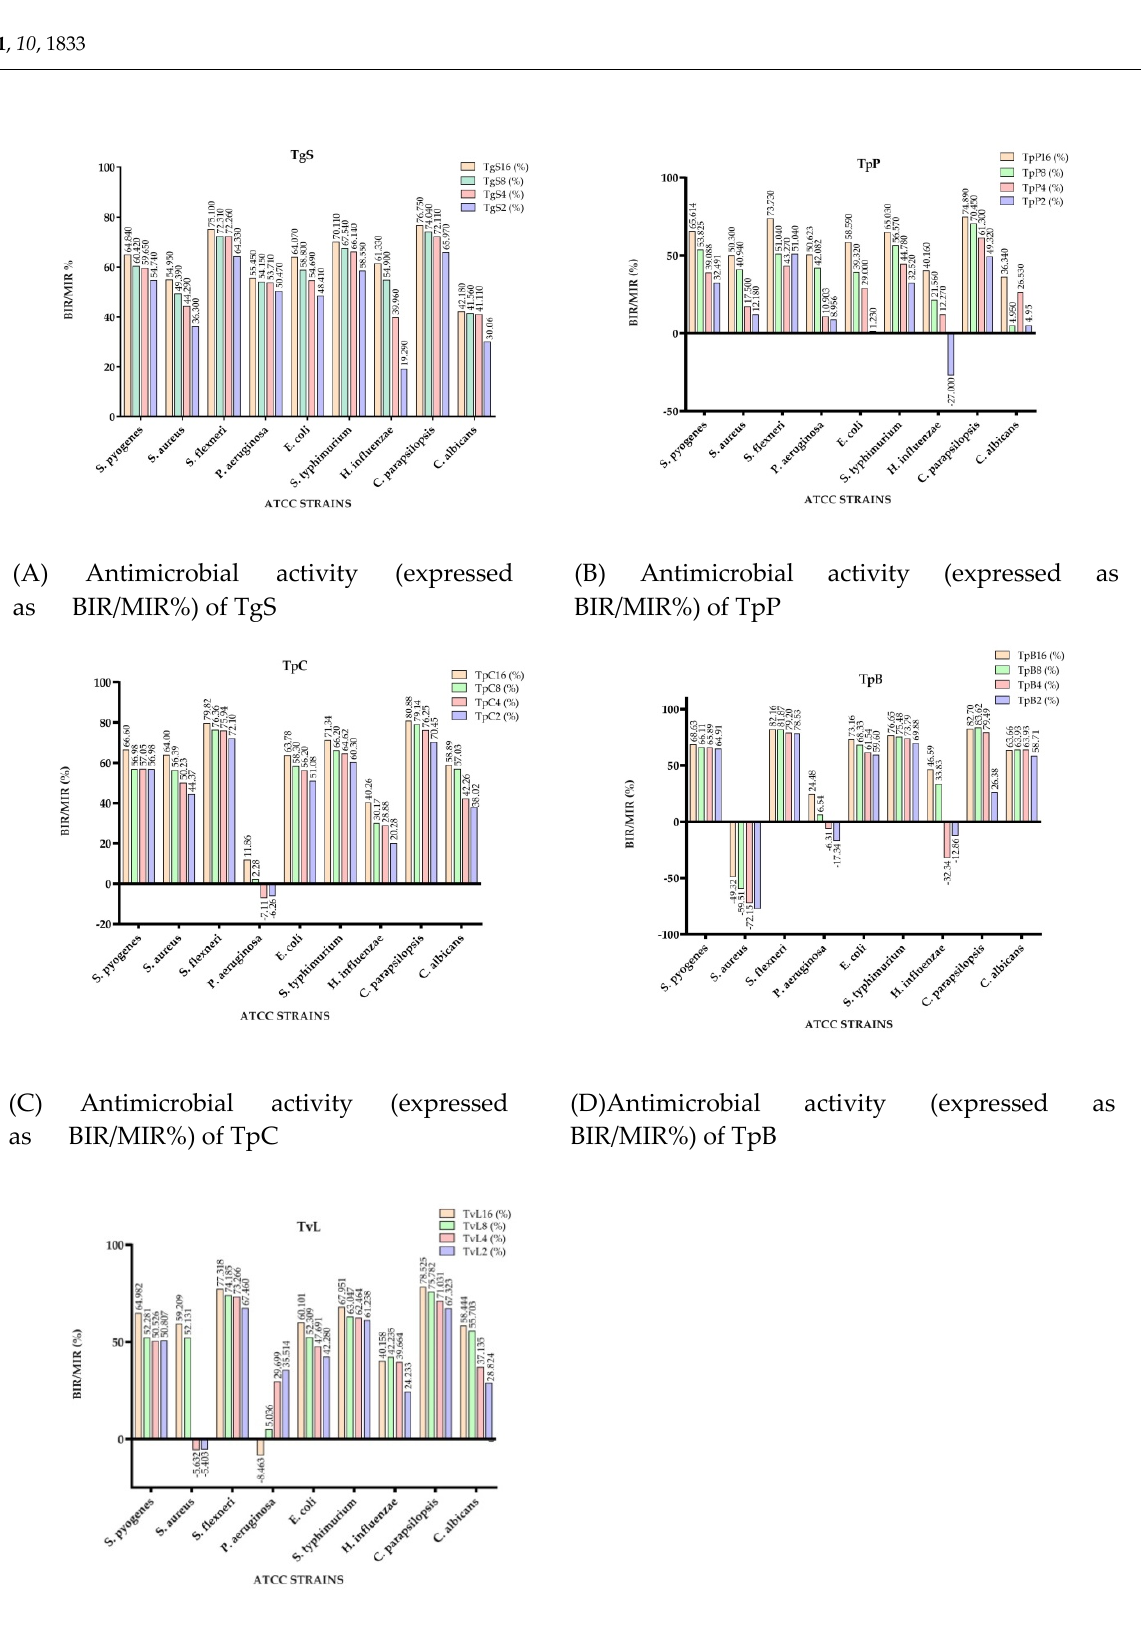
Figure 3. Antimicrobial activity of analyzed EOs expressed as BIR/MIR (%): ( A ) TgS; ( B ) TpB; ( C ) TpC; ( D ) TpP; ( E ) TvL. Table 3. The optical density (OD) mean values of EOs at 540 nm.